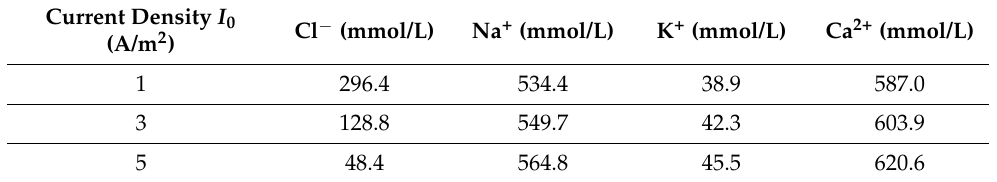
Table 3. Mean ionic concentrations in the vicinity of steel after the electrochemical treatment of different current